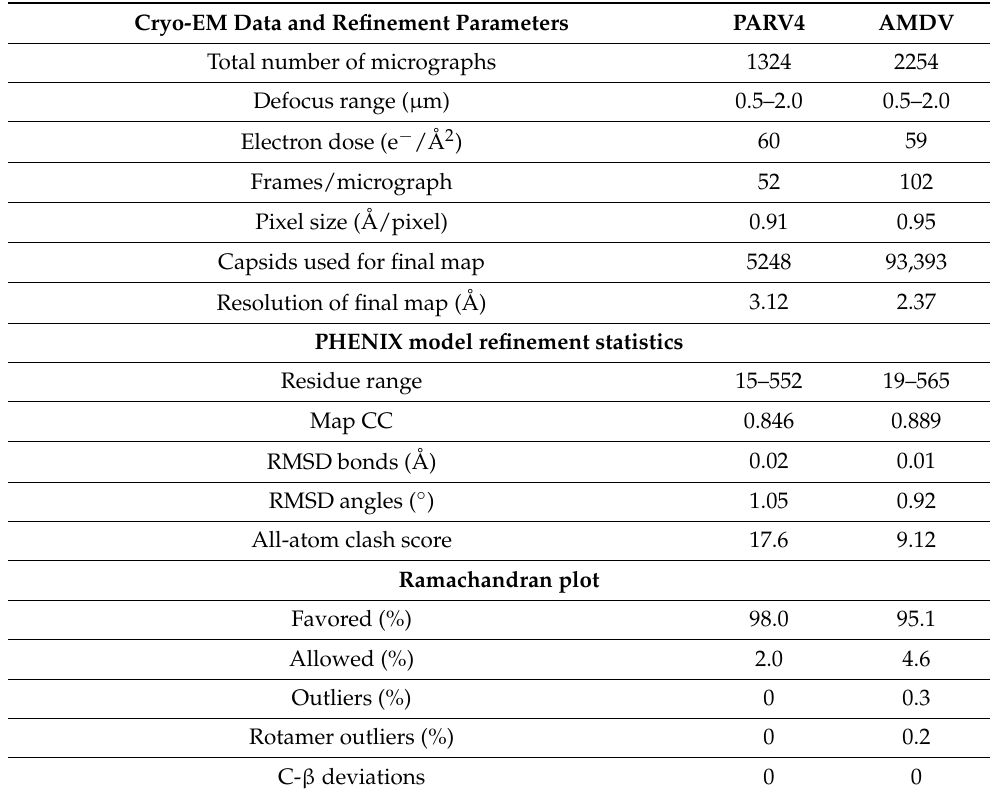
Table 1. Summary of cryo-EM data collection and refinement statistics for PARV4 and AMDV. Cryo-EM Data and Refinement